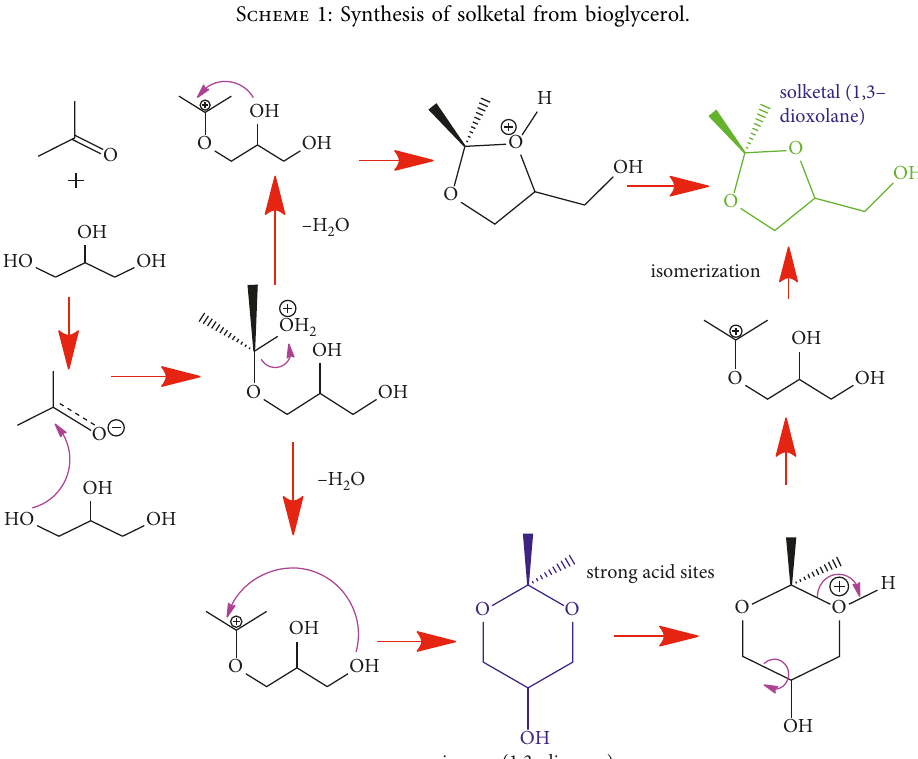
Scheme 2: Suggested mechanism for dioxolane synthesis in acetalization reaction.